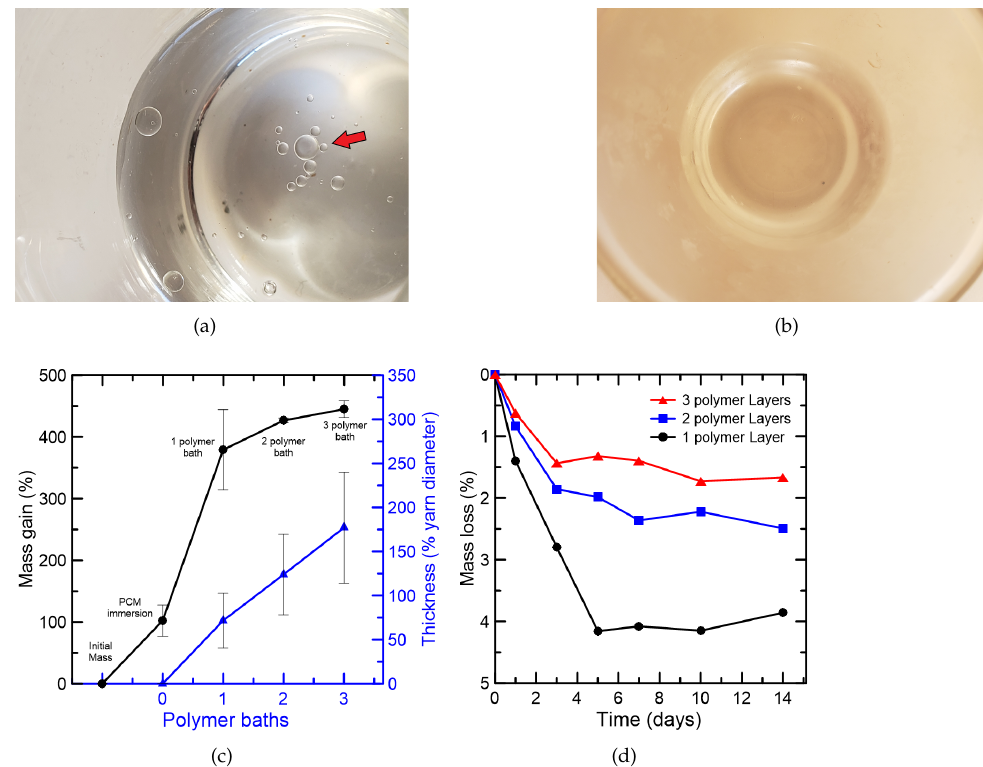
Figure 9. Evaluation of the effectiveness of the polymer coating on the jute fabrics: leakage of ( a ) in natura jute yarn and ( b ) XSBR-coated jute yarn, ( c ) mass and layer thickness during treatment and ( d ) mass loss after